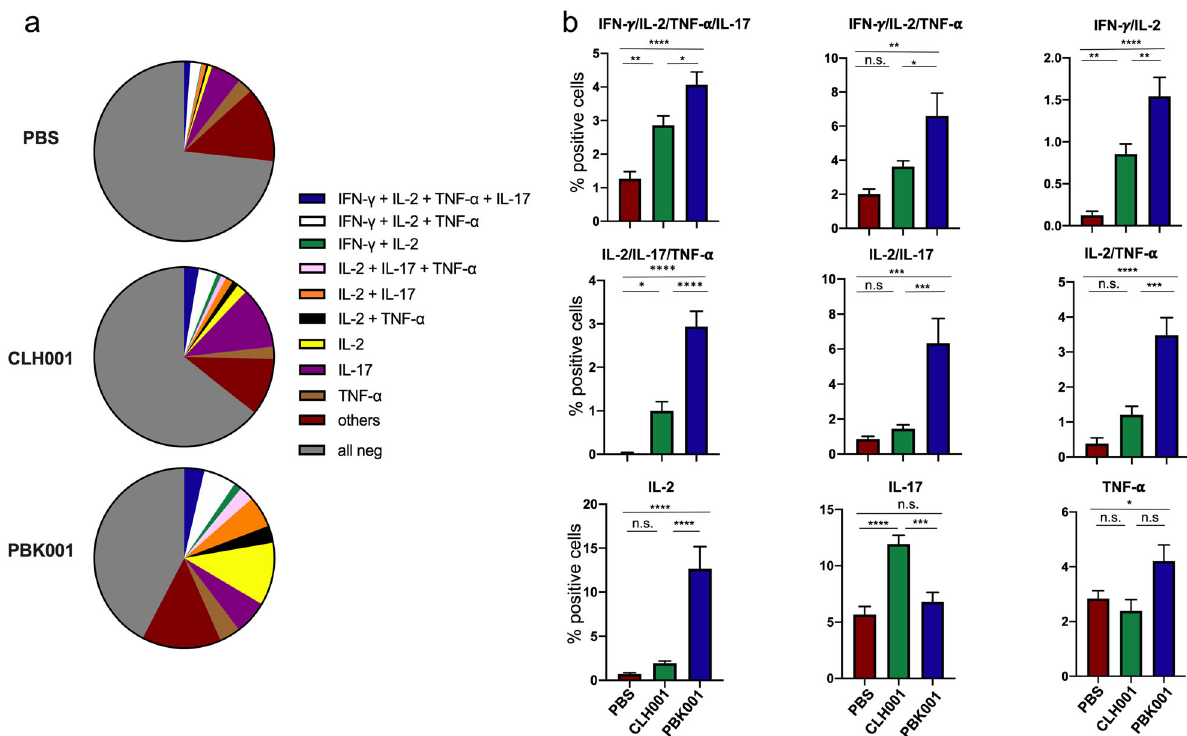
Fig. 5 Development of antigen-speci fi c and multi-functional CD4 + T-cell memory following vaccination. At day 21 post vaccination, lungs of C57BL/6 mice receiving PBS, CLH001, or PBK001 were collected and disrupted cells were co-cultured with BSA (mock) or BMDC pulsed with 1 μ g of heat-killed Bpm K96243 WCL. The cultured cells were harvested after incubation at 37°C and 5% CO 2 for 72 h, with addition of a Golgi protein transport inhibitor during the last 4 h of incubation. CD4 + T-cell recall was assessed by using fl ow cytometry to detect surface phenotype (CD3, CD4) and intracellular cytokines (IL-2, TNF- α , IFN- γ , and IL-17). Flow cytometry data were analyzed using FlowJO software including use of Boolean gate analysis to assess the frequency of multifunctional CD4 + T-cell populations. a Pie charts of background- subtracted Boolean gating analysis of selected mono-functional and poly-functional cytokine-producing CD4 + T cells following antigen- speci fi c stimulation. b Comparisons among vaccine groups for polyfunctional outcomes. Pie slices in a represent the average, while bars in b represent the mean ± SEM of data from 10 mice pooled pairwise, in each vaccine group. Data are representative of three independent experiments with similar results. Remaining comparisons are shown in Supplemental Fig. 3. * p < 0.05, ** p < 0.01, *** p < 0.001, **** p < 0.0001, n.s. = not signi fi